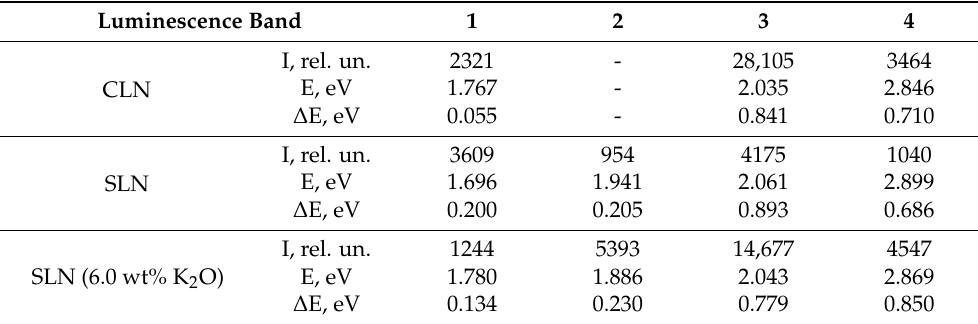
Table 3. Spectral characteristics of individual volume PL bands of the crystals under